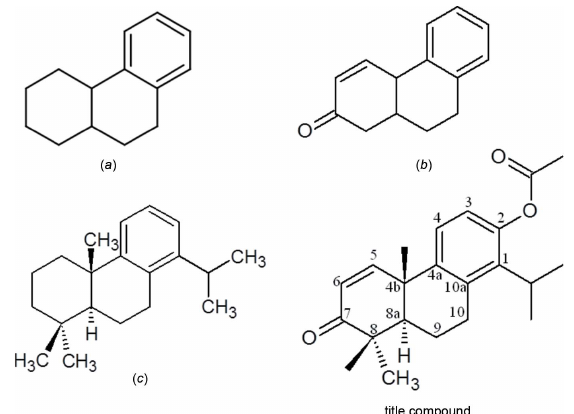
Figure 4 The core structures for database survey: ( a ) 1,2,3,4,4a,9,10,10 a -hexa- hydrophenanthren, and its ( b ) 7-oxo with double bond between C5 and C6, ( c ) 1-isopropyl-4 b,8,8-trimethyl substituents; and ( d ) the title compound.